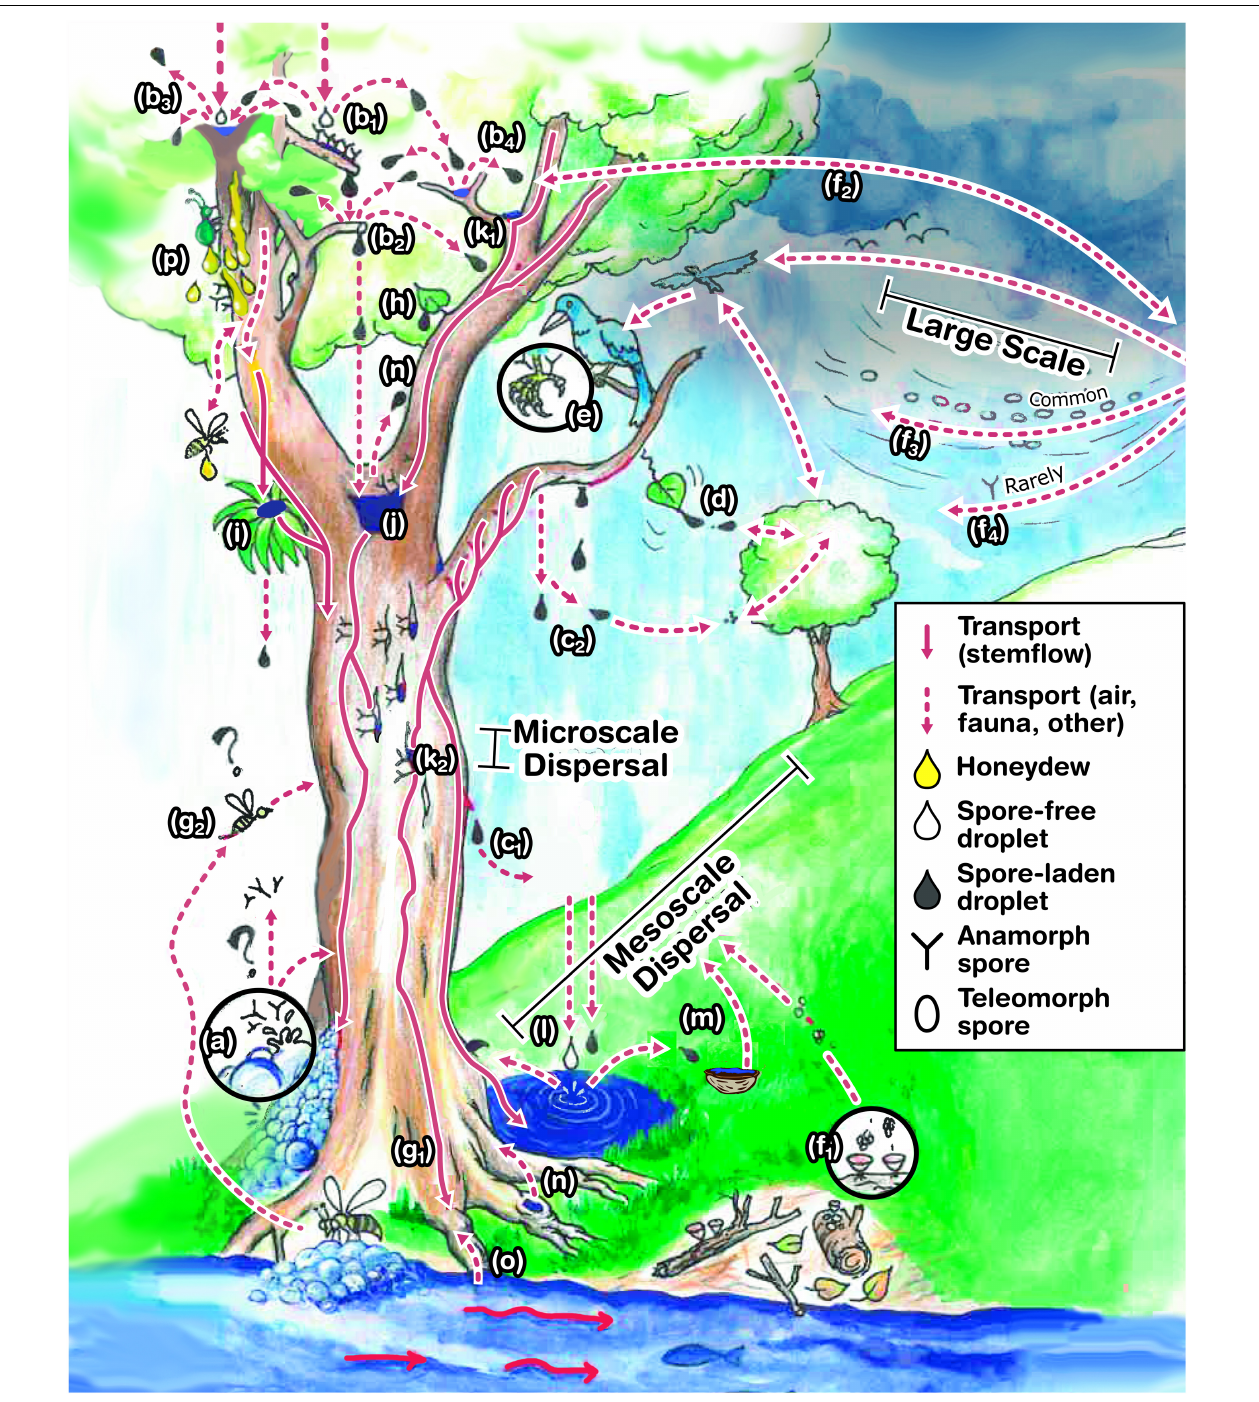
FIGURE 5 | Illustration synthesizing the hypothesized source, fate and transport of Ingoldian and dendronatant conidia found in stemflow, including: (a) bubbles; (b) splash; (b 1 ) spore-free rain droplet hits a fungal colony; (b 2 ) a spore-laden drop accumulated at the end of twig; (b 3 ) spore-free rain droplet hits spore-laden water film; (b 4 ) spore-laden droplet hits spore-laden water film; (c) aerosolized stemflow from (c 1 ) drips from branches and (c 2 ) bark extremities; (d) shaking release and dispersal; (e) epi-faunal exchange; (f) wind dispersal of teleomorph spores (f 1 ) from local or (f 2 − 3 ) distant sources; and (f 4 ) while airborne dispersal of anamorphs seems to be rare; (g 1 , 2 ) exchange by invertebrates visiting streams; phytothelmata in epiphytes; (h) throughfall; overflow from (j) treeholes, (k) aquatic microhabitats in (k 1 ) branch junctions and (k 2 ) bark fissures (note that some is filled with rainwaters while others are out of the way of rivulets and consequently remains dry, some of them of low fungal growth; (l) rain and throughfall generates splash transfer between tree, stream and nearby puddles, (m) micro-thelmata (e.g., walnut shells) and (n) treeholes; (o) endophytic colonization and dispersal; and (p) spore capture and transport due to honeydew flow and attracted invertebrates.